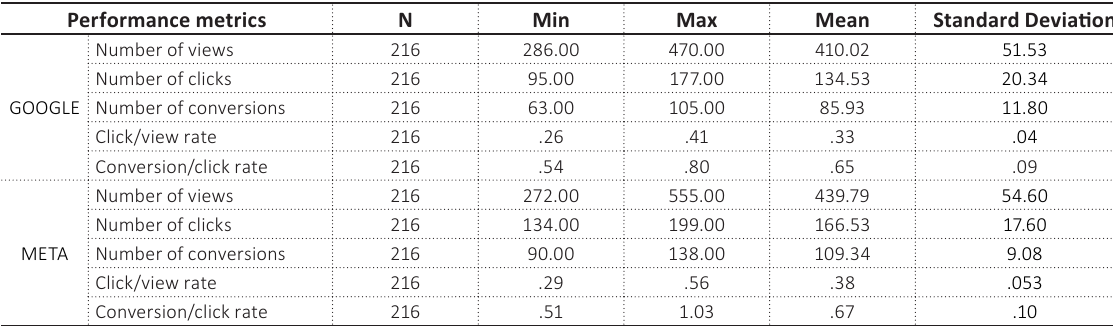
Table 3. Summary statistics for the 2022 data set